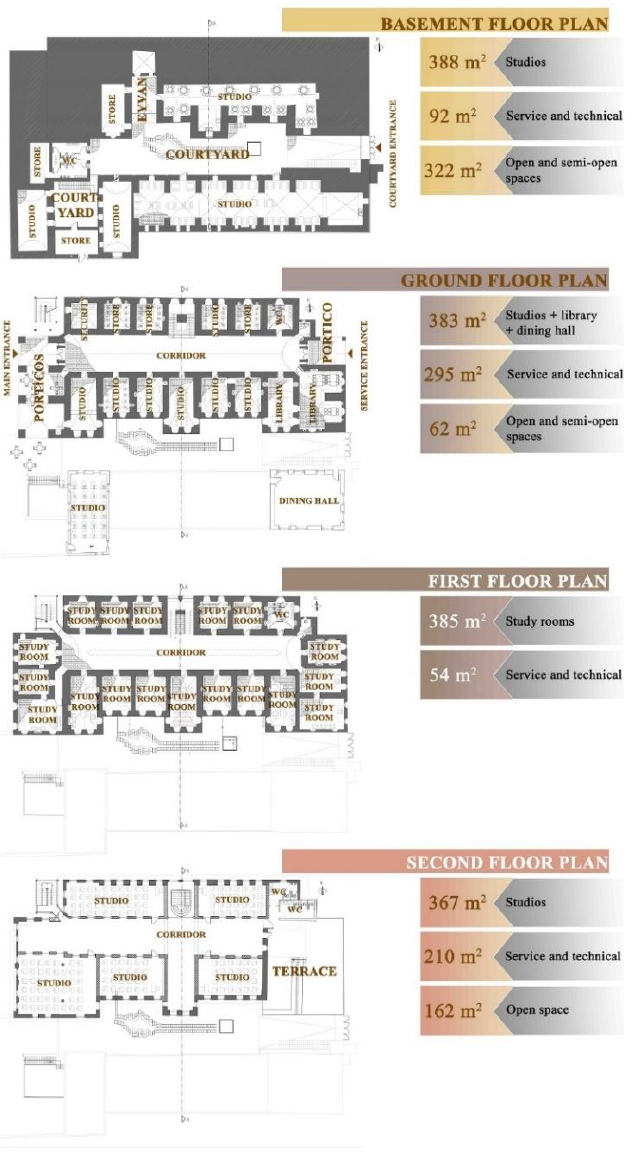
Fig. 11. Floor plans and spaces of the faculty [Created by the